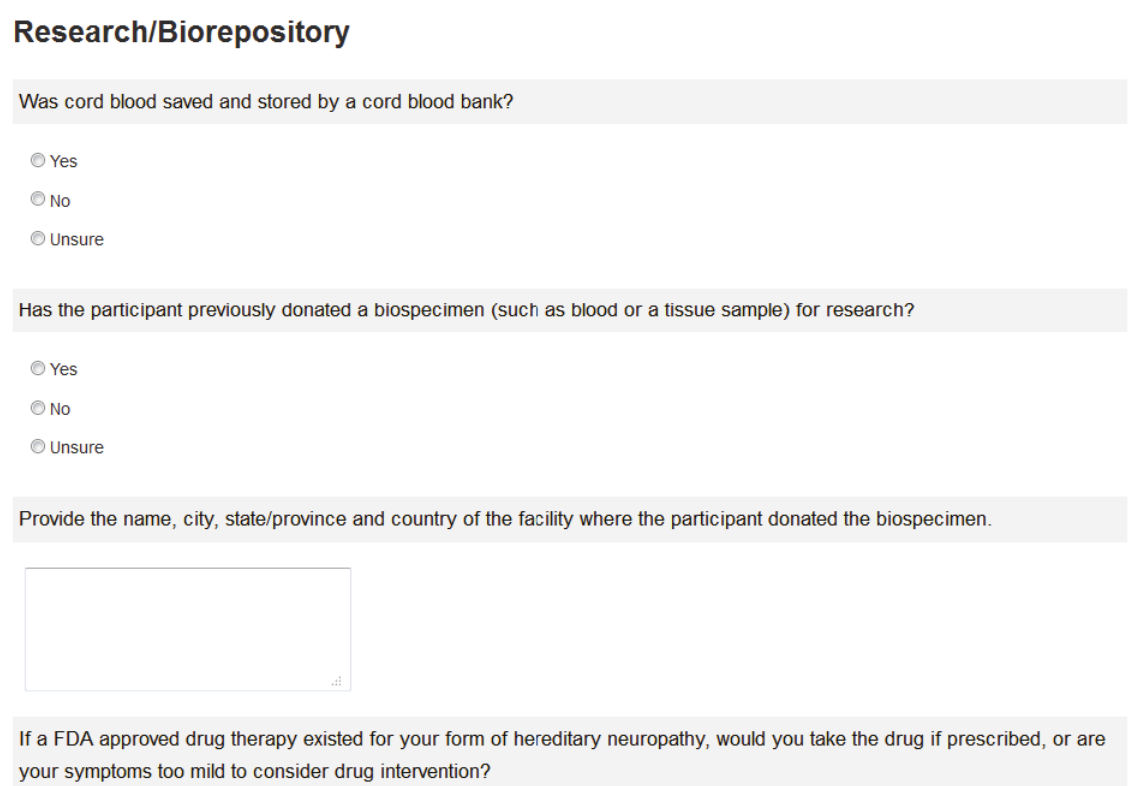
Supplemental Figure 9.